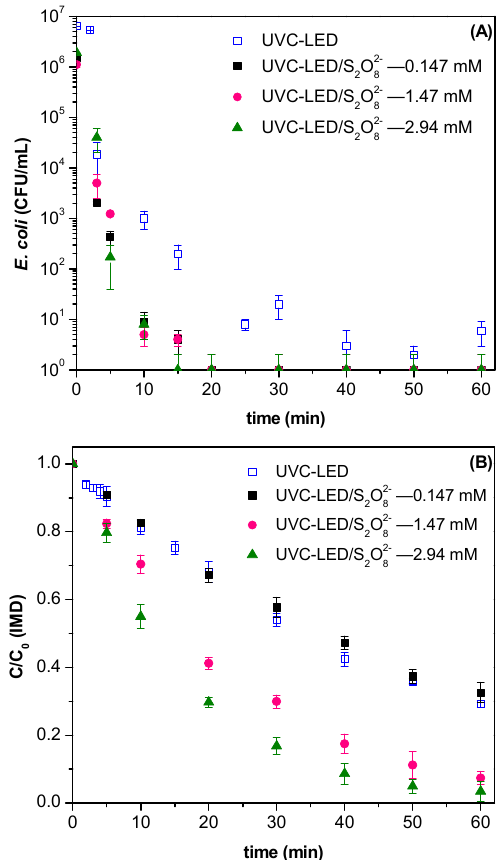
Figure 4. Effect of initial concentrations of S 2 O 82 − (0.147, 1.47, and 2.94 mM) on simultaneous E. coli inactivation ( A ) and IMD removal ( B ) by the UVC-LED/S 2 O 82 − process.